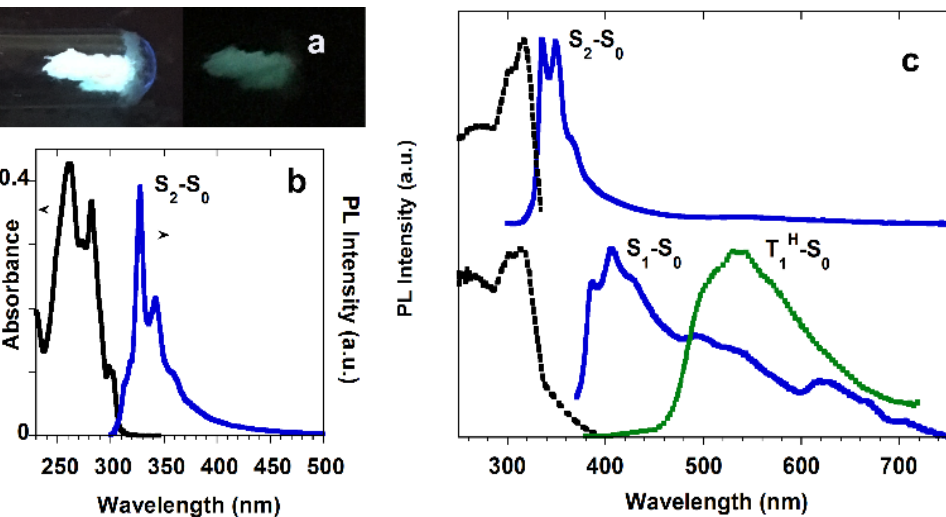
Figure 6. Compound 30 . ( a ) Powders at 77 K with UV irradiation on (left) and off (right). ( b ) In DCM at RT: absorption and emission (blue line, λ ex = 260 nm). ( c ) Powders at RT: Top: excitation (dashed black line, λ em = 348 nm) and emission (blue line, λ ex = 260 nm). Bottom: excitation (dashed black line, λ em = 408 nm), emission (blue line, λ ex = 370 nm) and phosphorescence (green dotted line, 10 ms delay, window 50 ms, λ ex = 358 nm). Reprinted with permission from [48].